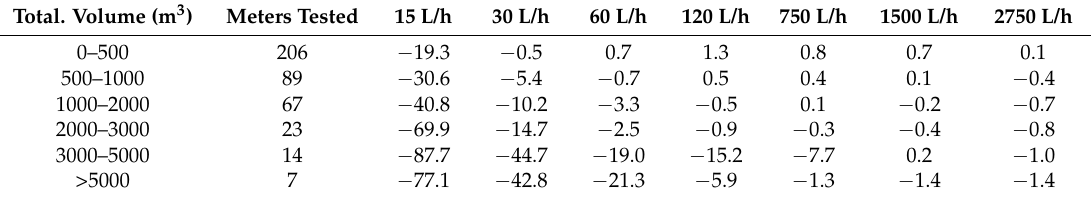
Table 5. The average error of indication (%) of meter type M_1 classified by totalised volume.